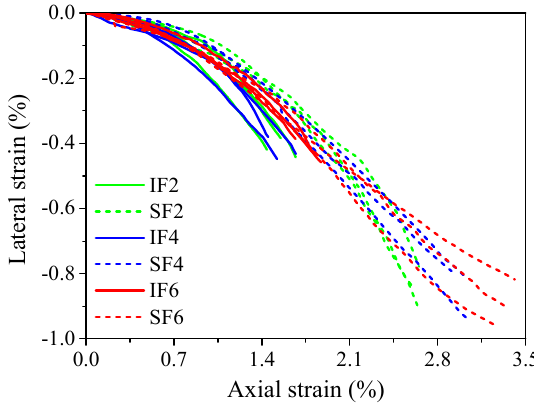
Figure 11. Lateral strain vs. axial strain responses of confined ice.